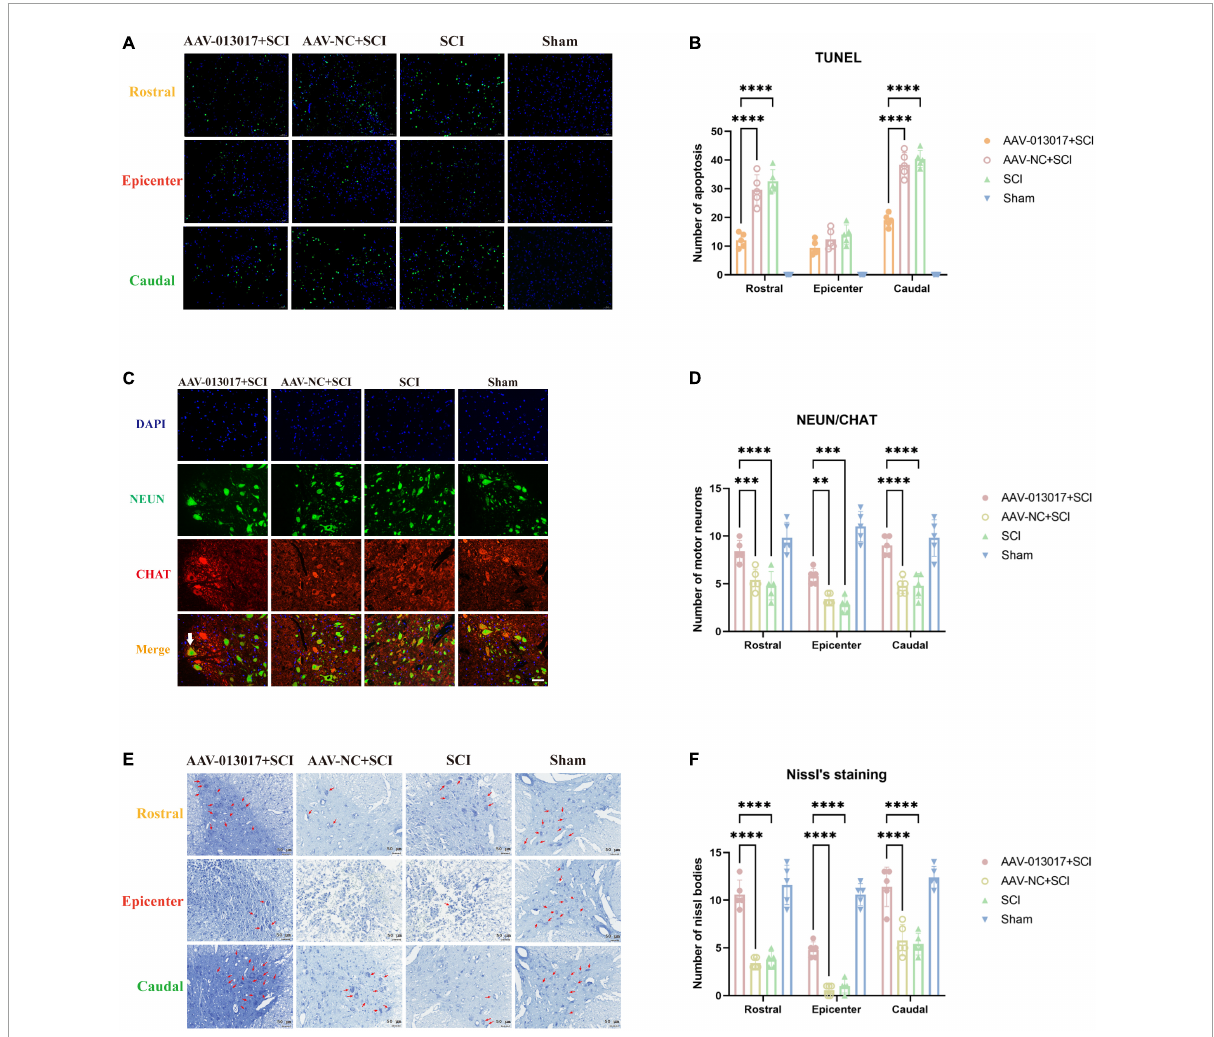
FIGURE2 Inhibition by rno-circRNA-013017 of the apoptosis of motor neurons in the spinal anterior horn at 3 days after SCI. (A) In the rostral and caudal adjacent segments and epicenter, apoptotic neurons in the anterior horn were identified by terminal deoxynucleotidyl transferase dUTP nick-end labeling (TUNEL), as indicated by the green points ( n = 5 per group). (B) In the rostral adjacent segment, neurons marked by NeuN and motor neurons marked by ChAt in the anterior horn area were shown in all groups. The white arrow indicates a typical motor neuron with an irregular cell body, nucleus, axon, dendrite, and other cell structures ( n = 5 per group). (C) In the epicenter, few normal neurons and motor neurons in the anterior horn area were seen in the three groups subjected to SCI ( n = 5 per group). (D) In the caudal adjacent segment, neurons marked by NeuN and motor neurons marked by ChAt in the anterior horn area were shown in all groups. The white arrow indicates a typical motor neuron with an irregular cell body, nucleus, axon, dendrite, and other cell structures ( n = 5 per group). (E) Nissl bodies, indicated by red arrows, in the anterior horn area were seen in all groups ( n = 5 per group). AAV-NC (negtive control) means AAV with transfected empty plasmid without target gene, compared to AAV with target gene. (F) Number of nissl bodies. ∗∗∗∗ Indicates p < 0.0001; ∗∗∗ indicates p < 0.001; ∗∗ indicates p <